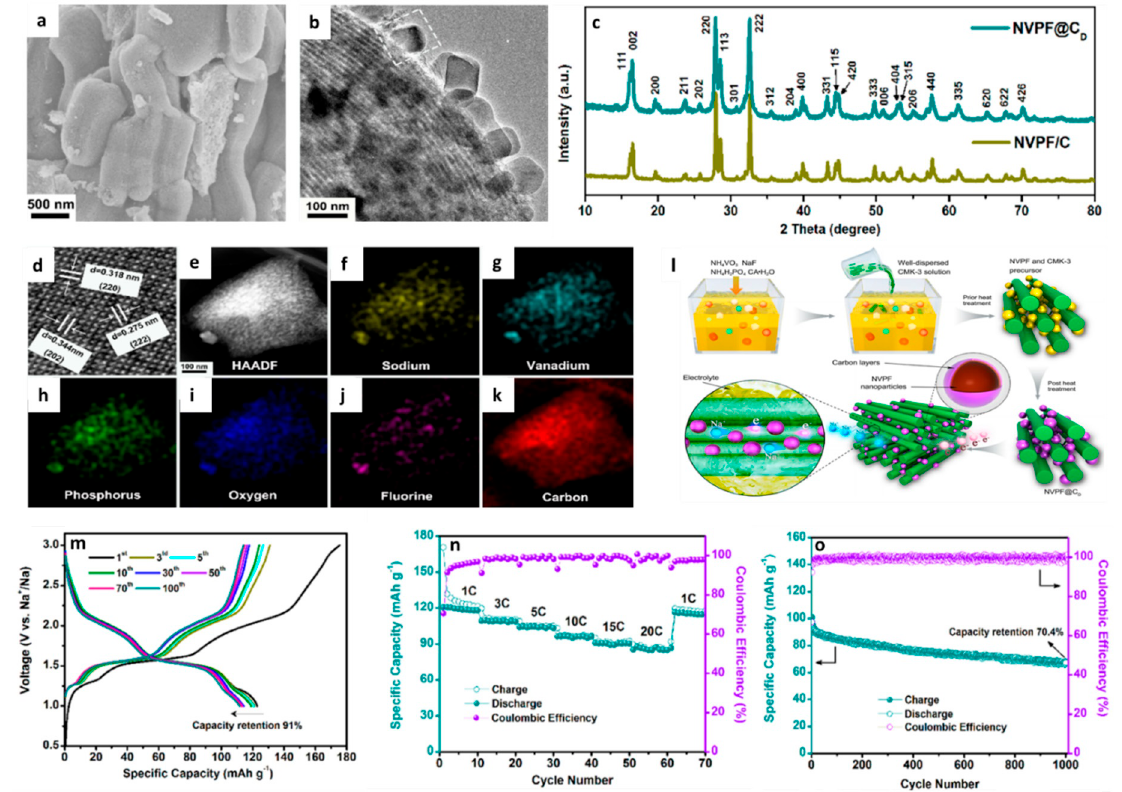
Figure 12. Structural characterization and electrochemical performance analysis of NaFePO 4 /C composite as a cathode in SIBs. ( a ) SEM images of the Na 3 V 2 (PO 4 ) 2 F 3 @C (NVPF/C) composites exhibiting bead like morphology. ( b ) TEM image showing the morphology demonstrating the “worm-like” mesoporous structure. ( c ) XRD pattern of NVPF sample with the core-double shell structure (NVPF@C d ) in comparison with the NVPF sample with just simple carbon coating (NVPF@C), demonstrating the characteristic peaks. ( d ) FFT image of the NVPF@Cd sample clearly demonstrating the carbon coating in the nanocomposite. ( e – h ) Elemental maps of the NVPF@C d composite depicting the constituent elements uniformly distributed. ( j ) Schematic representation of the synthesis of the NVPF@Cd nanocomposite from its precursors. ( k ) Galvanostatic charging-discharging curves of the half-cell with NVPF / C d cathode for various cycles. ( l ) Rate performance demonstration of the nanocomposite electrode showing its performance at varying C rates. ( m ) Capacity retention of the NVPF@C d composite and its corresponding coulombic e ffi ciency. Copyright 2016, American Chemical